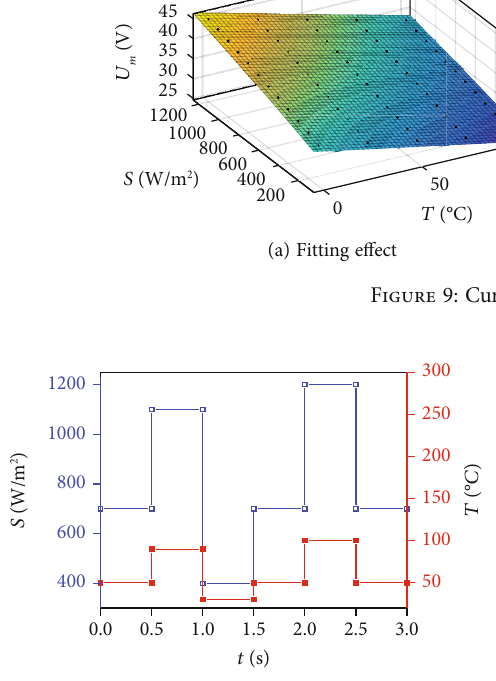
Figure 10: Variations of solar irradiance and